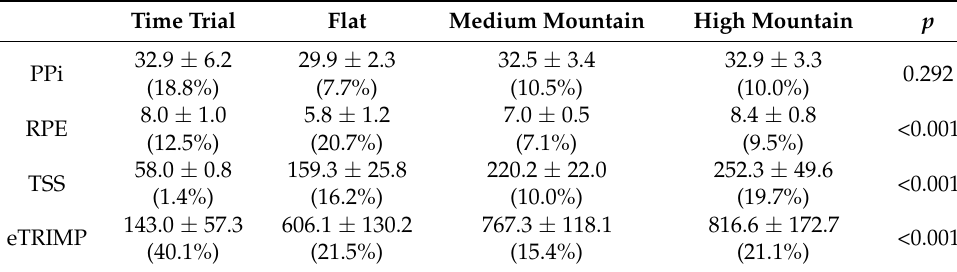
Table 4. Differences in the intensity quantification indexes regarding the stage type during the 2018 Tour de France.